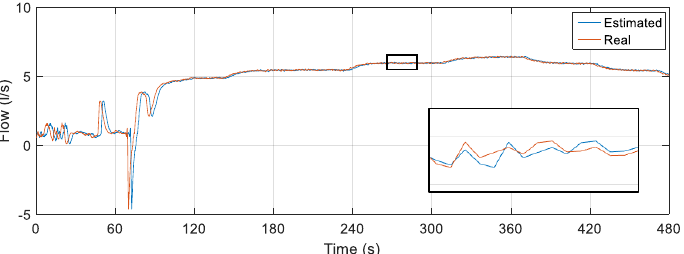
Figure 20. Estimated versus actual flow with the plant controlled for different desired pressure values.